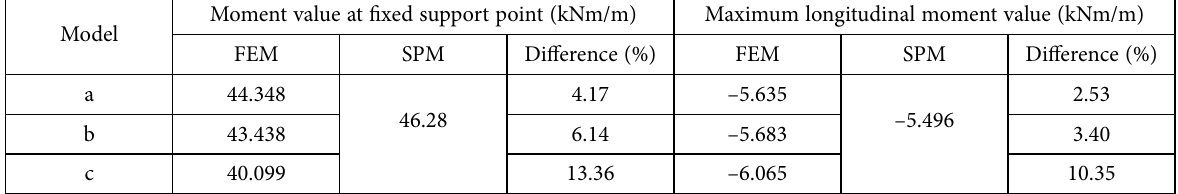
Table 4. The difference between FEM and SPM for same aspect